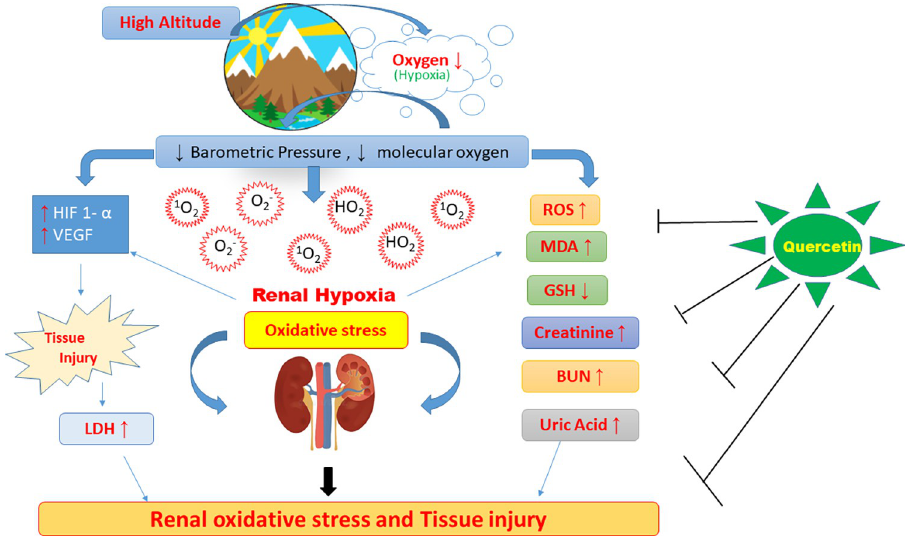
Fig 13. Schematic representation of altered renal functions with elevated oxidative stress under hypobaric hypoxia and plausible mechanism of their prevention by quercetin administration in rats. ROS—Reactive oxygen species, MDA- Malondialdehyde, GSH- reduced glutathione, BUN—Blood urea nitrogen, HIF-1 α —Hypoxia inducible factor 1 alpha, VEGF-Vascular Endothelial Growth Factor, LDH- lactate dehydrogenase. " -Upregulation, # - Downregulation, ? -